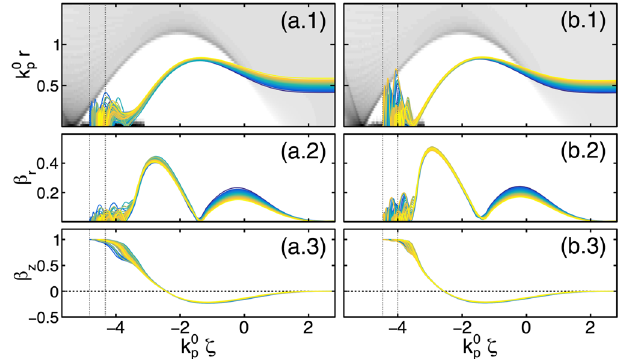
acceleration.FIG. 10. Trajectory of the macroparticles originated from the same initial plasma density range (from 2 . 00 n 0 to 2 . 03 n 0 ) for two different ramp length cases (a) and (b). (Top) Radial distance to the beam axis r , (middle) “ transverse velocity ” β r ¼ p r = ð mc γ Þ , (bottom) longitudinal velocity β z ¼ p z = ð mc γ Þ versus the comov- ing variable ζ . In the top panels, we plot for reference the particle distribution of the plasma electrons after the injection process has been